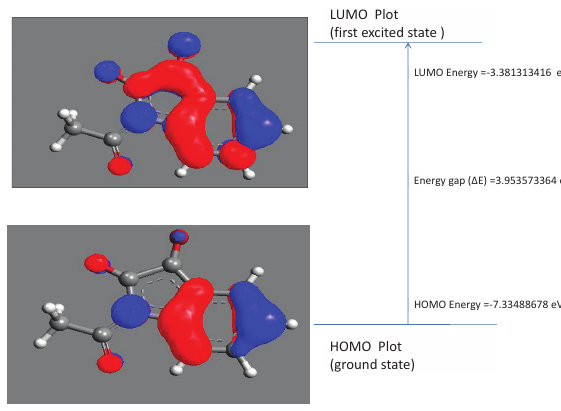
Figure 5 : Molecular electrostatic potential map of N -acetylisatin calculated at B3LYP/6 311++G(d,p) level.